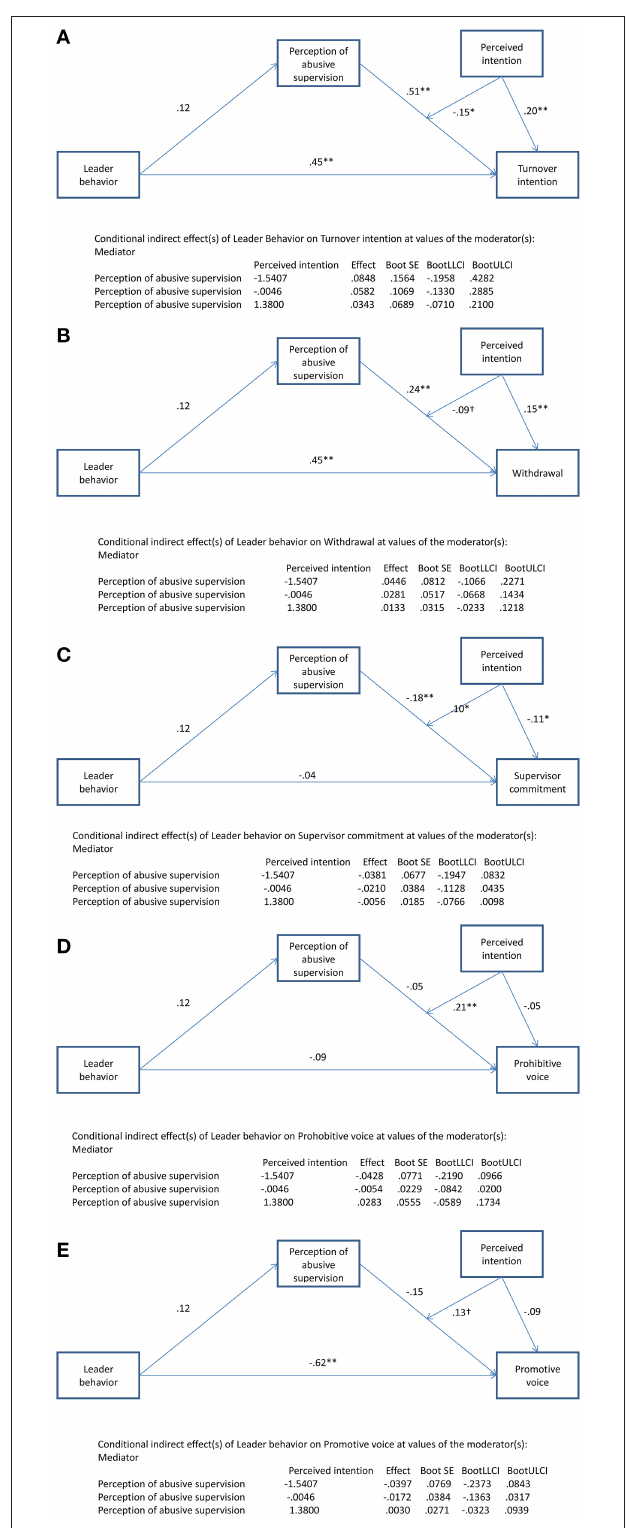
FIGURE 4 | (A–E) Moderated mediation of intention and perception of abusive supervision on the relationship between abusive supervision behavior and reactions (including negative affectivity as control, only abusive vignettes) Study 2. † p < 0.10 (2-tailed), * p < 0.05 (2-tailed), ** p < 0.01